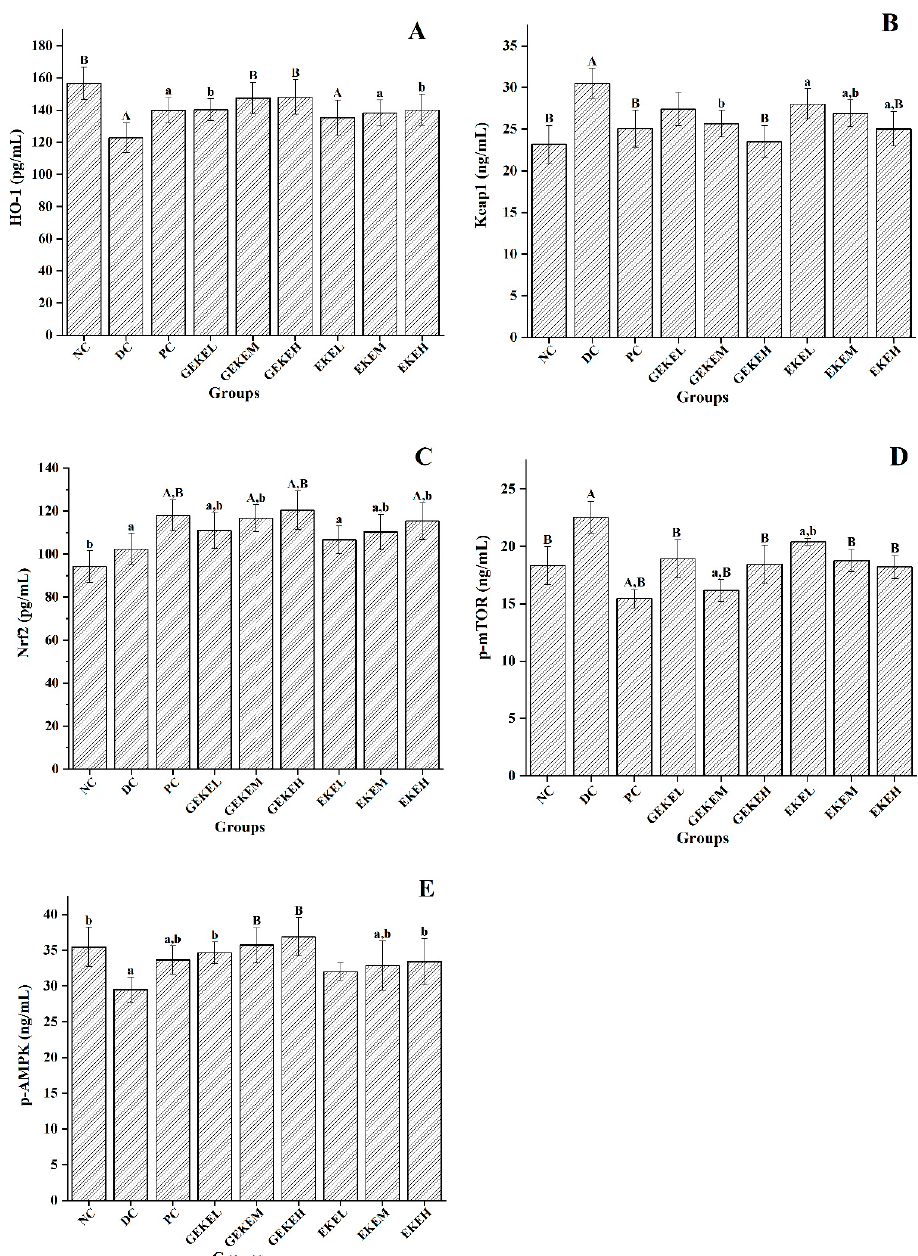
Figure 6. The protein expression in each group of mice. ( A ) HO-1 levels of the mice. ( B ) Keap1 levels of the mice. ( C ) Nrf2 levels of the mice. ( D ) p-mTOR levels of the mice. ( E ) p-AMPK levels of the mice. Note: n = 10 per group. A ( p < 0.01) and a ( p < 0.05) indicate comparison to the normal control; B ( p < 0.01) and b ( p < 0.05) indicate comparison to the diabetes control. According to the mRNA and protein expression results of key renal oxidative stress genes, the regulation effect of high-dose EKE on HO-1 and p-mTOR levels is similar to that of low-dose GEKE. The effect of high-dose EKE on regulating Keap1 and Nrf2 levels was similar to that of medium-dose GEKE. The effect of low-dose GEKE on the regulation of p-AMPK level was significantly better than that of high-dose EKE. It can be seen that GEKE has a more stable effect in regulating the expression of the AMPK/mTOR and Keap1/Nrf2/HO-1 signaling pathways, and low-dose GEKE is enough to make a difference with the DC